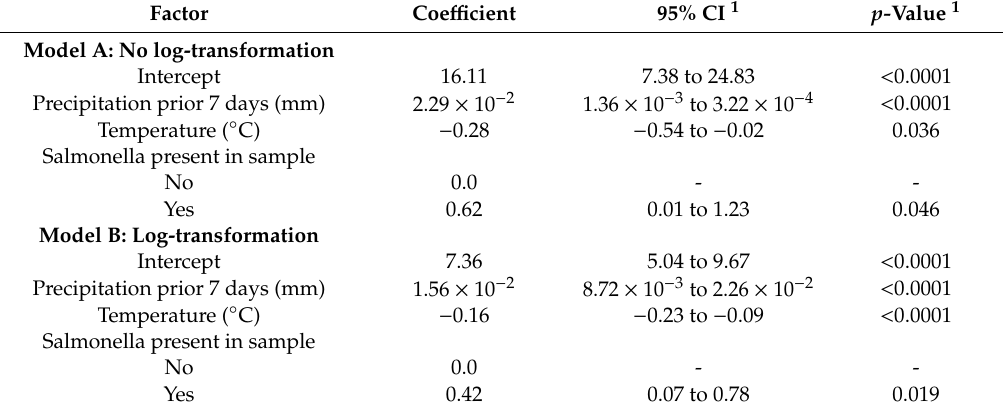
Table3. Mixed-e ff ectsregressionmodelsbetweennolog-andlog-transformeddataoftheconcentrations of E. coli collected from pooled oyster from March 2016 and February